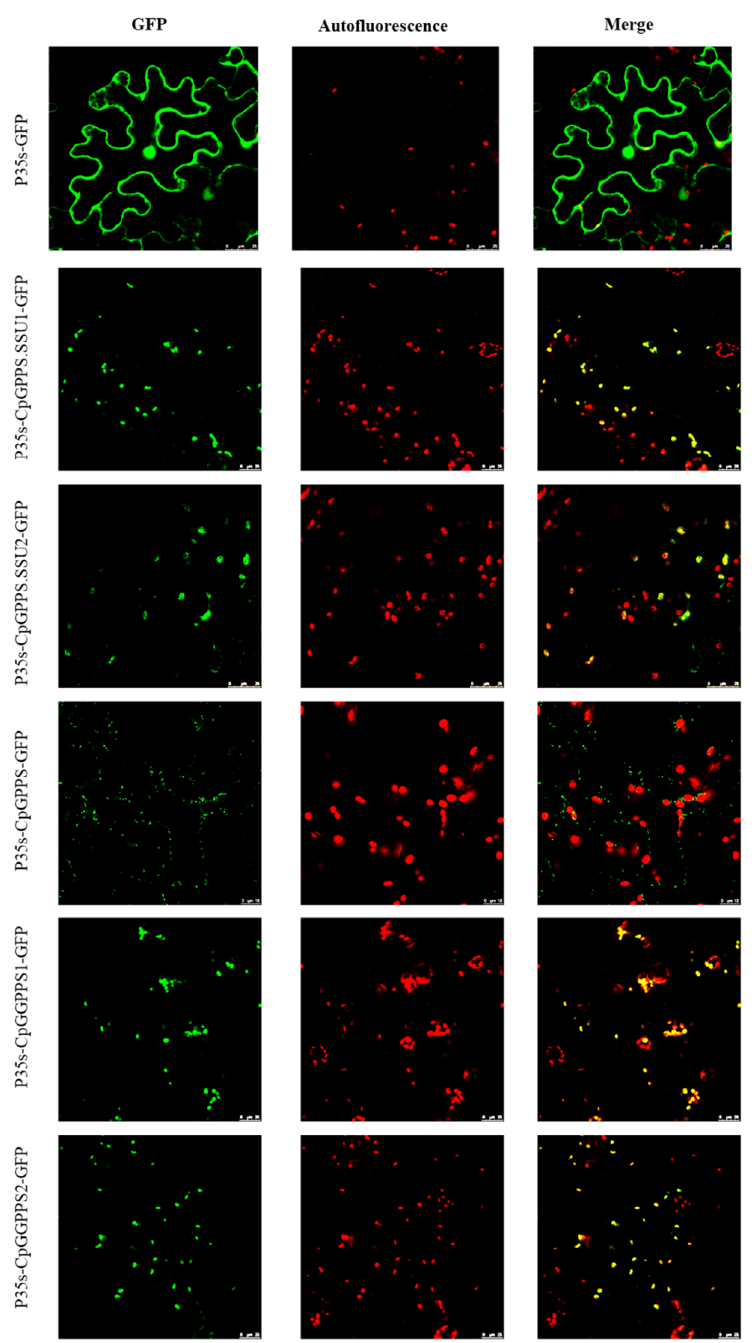
Figure 4. Subcellular localization of Cp GPPS.SSU1, Cp GPPS.SSU2, Cp GPPS, Cp GGPPS1, and Cp GGPPS2 in the N. benthamiana leaves. GFP signals from the adaxial leaf surface were observed by